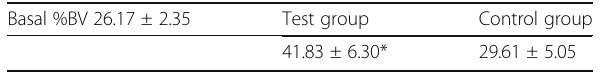
Table 1 Basal bone volume percentage (basal %BV) was compared to %BV around implants after 2 months of healing in both groups. %BV in the test group was significantly higher than basal %BV ( P < 0.05)